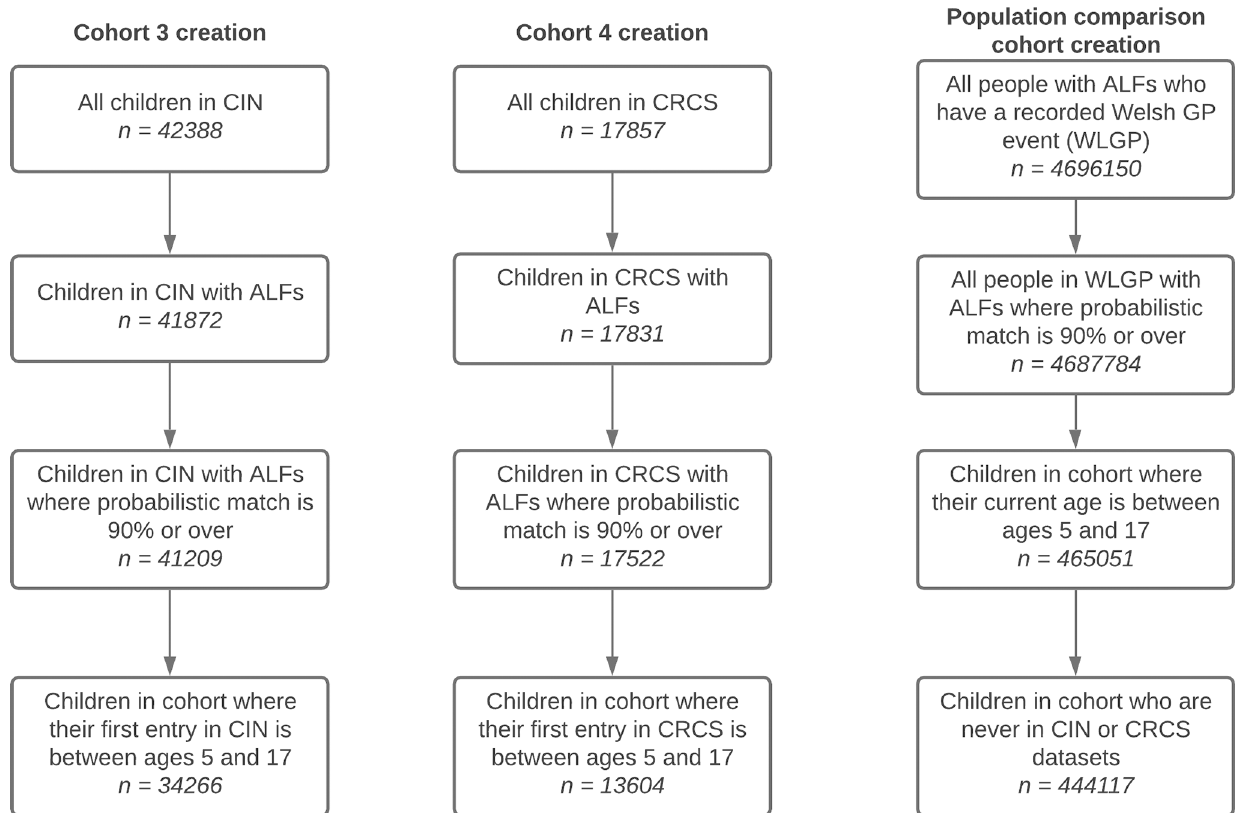
Figure 2: The process for creating each cohort, including the size of the cohort at each